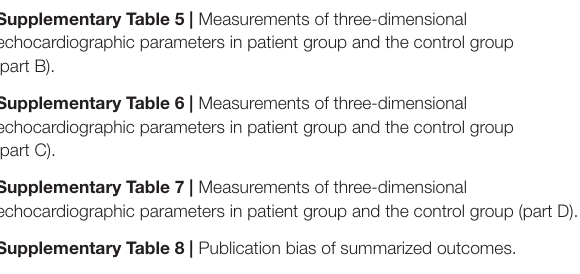
Supplementary Figure 2 | Mean differences in pooled three-dimensional echocardiographic parameters between patients and controls. Supplementary Table 1 | Characteristics of study participants. Supplementary Table 2 | Quality assessment of included studies by Newcastle-Ottawa Scale. Supplementary Table 3 | Measurements of two-dimensional echocardiographic parameters in patient and control groups.